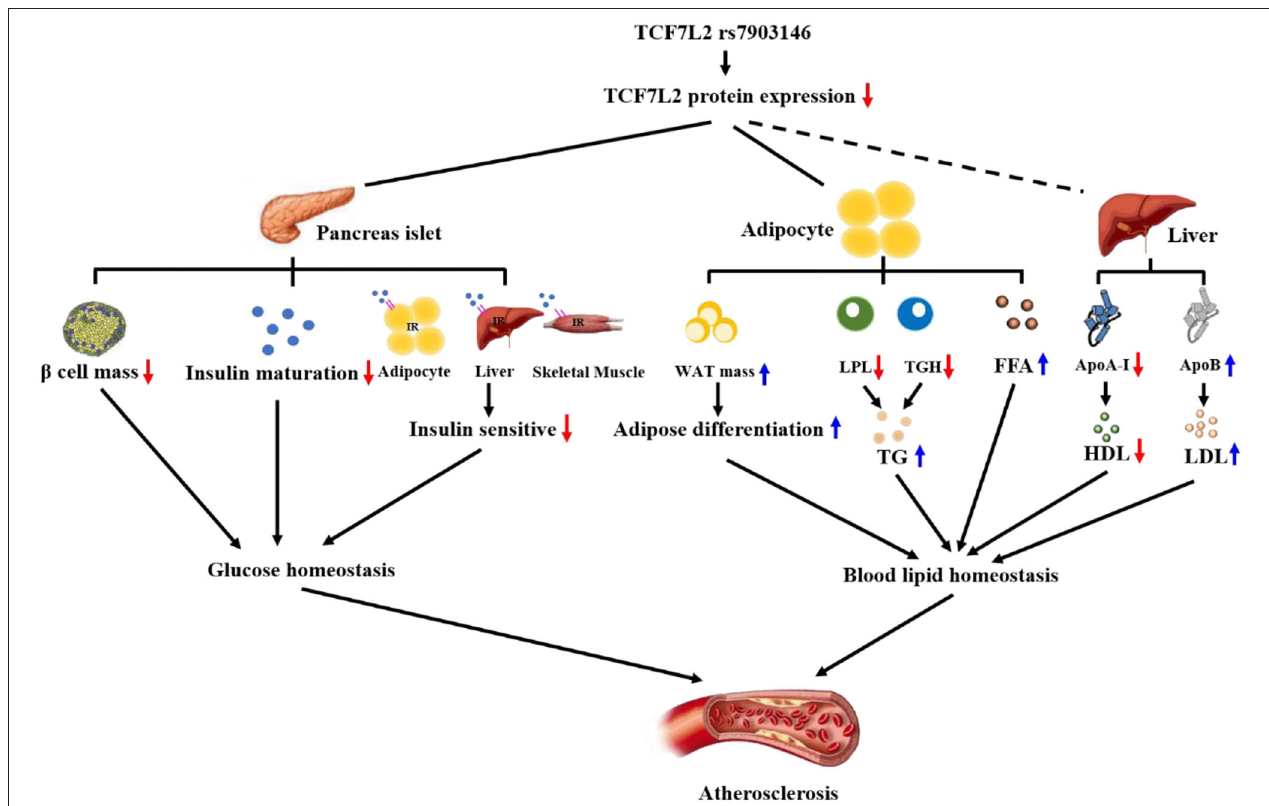
FIGURE 3 | TCF7L2 rs7903146 is a link between metabolism disorders and atherosclerosis. TCF7L2 rs7903146 inhibits the expression of TCF7L2, thereby influencing glucose and blood lipid homeostasis. On the one hand, TCF7L2 rs7903146 induces hyperglycemia and insulin resistance by decreasing β -cell mass, proinsulin gene expression, Ca 2 + voltage-gated channel activity, and insulin sensitivity of cells. On the other hand, TCF7L2 rs7903146 disrupts blood lipid homeostasis by increasing white adipocyte tissue (WAT) mass and harmful lipid components and decreasing HDL